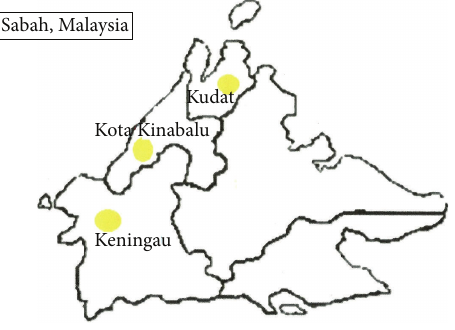
Figure 1: Map of study sites.